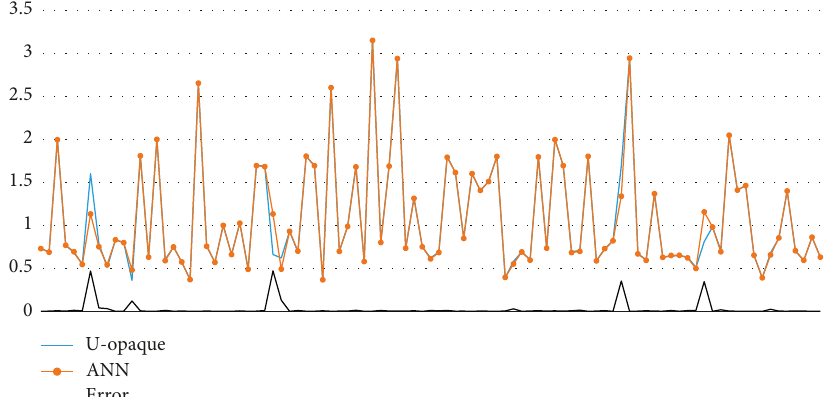
Figure 11: Comparison between measured and ANN predicted U-opaque values in single-family buildings.